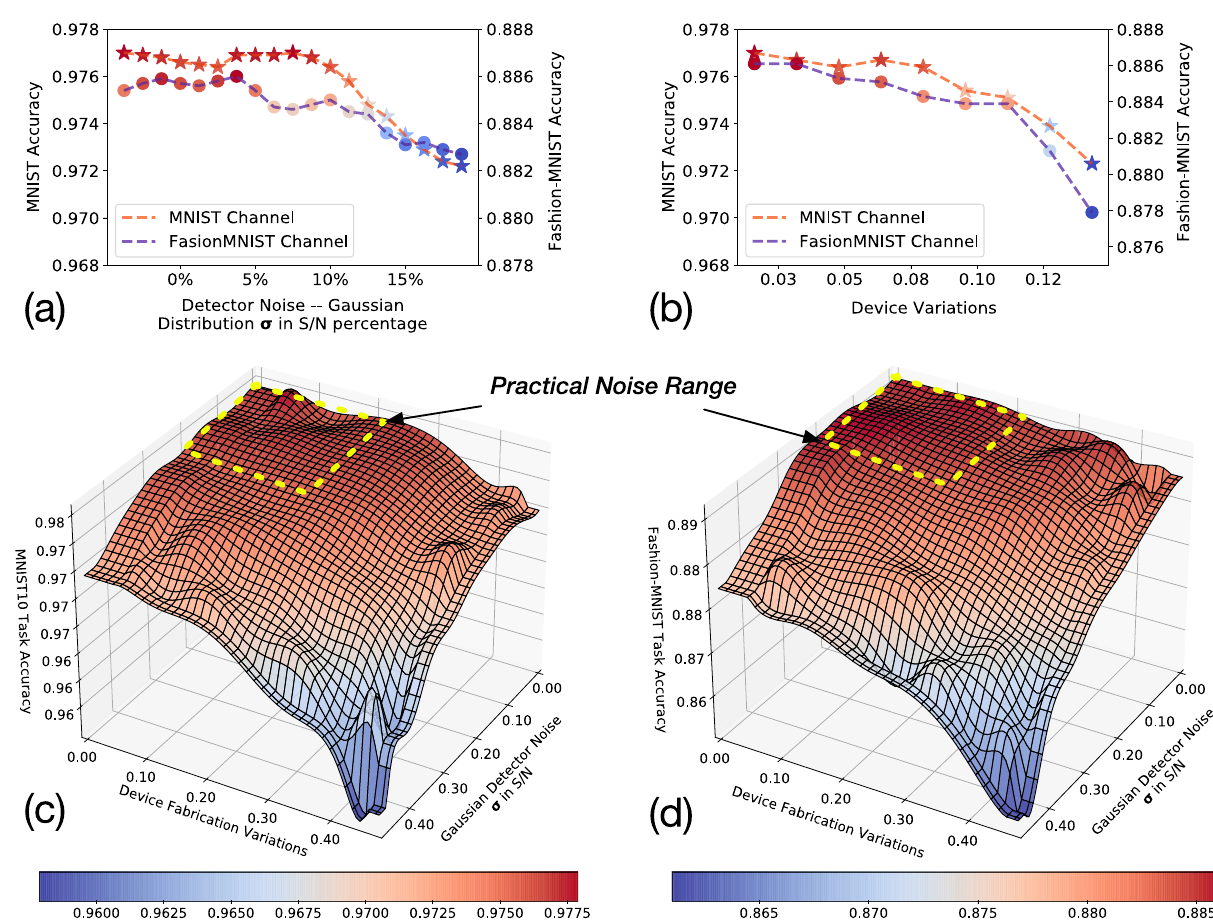
Figure 4. Evaluations of robustness against system noise of the proposed multi-task D 2 NN, by considering a wide range of Gaussian noise in detectors and device variations in phase modulators. Details of noise modeling in the proposed systems are discussed in Section Methods (Eqs. 8–10). ( a ) Prediction performance evaluation under Gaussian detector noise with σ shown in S / N (Signal to Noise) evaluation under Gaussian device variations. ( c ) Evaluations of MNIST task accuracy under combined detector noise and device variations. ( d ) Evaluations of Fashion-MNIST task accuracy under combined detector noise and device variations.